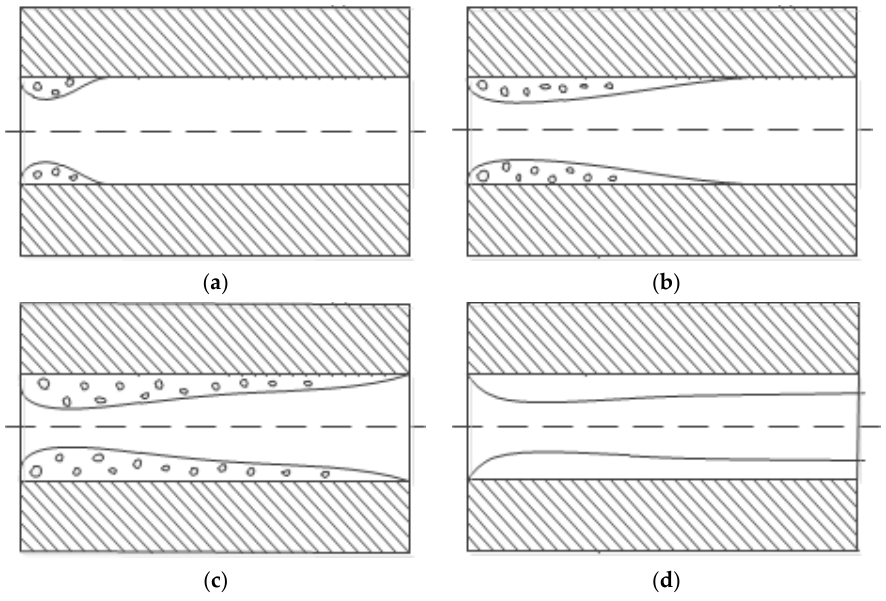
Figure 1. Status of cavitating flow. ( a ) Cavitation inception. ( b ) Cavitation growth. ( c ) Super cavitation. ( d ) Hydraulic flip.